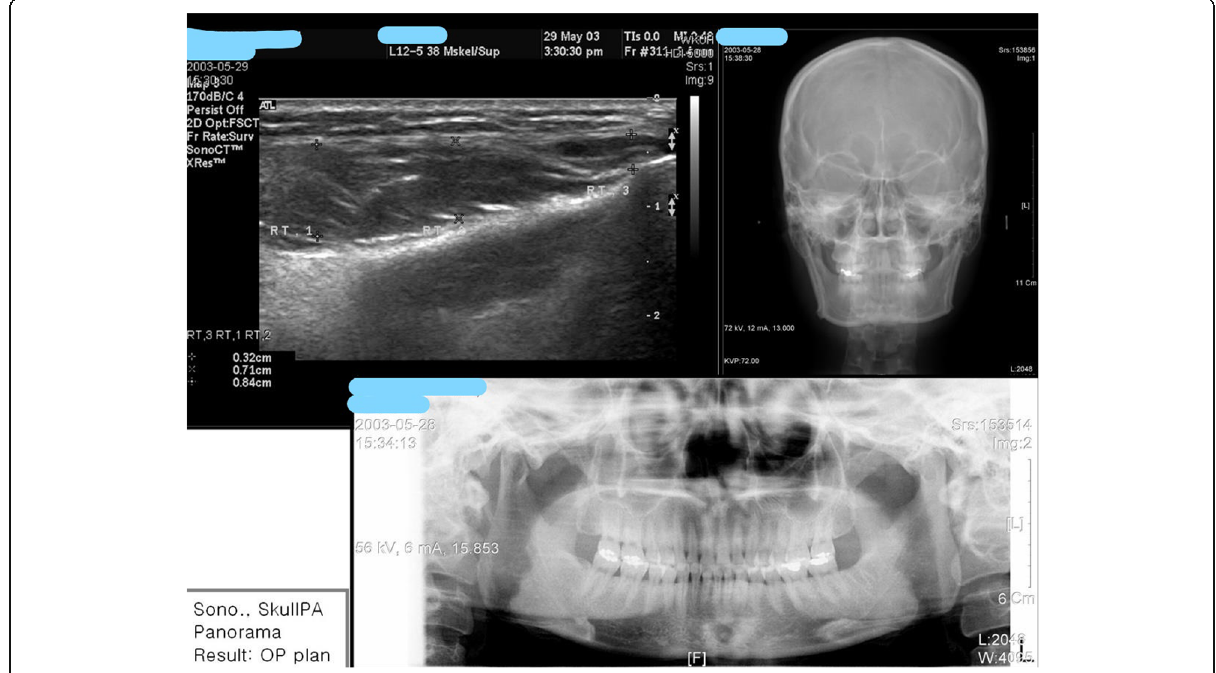
Fig. 9 For an initial assessment of bruxism and square jaw, with tests such as sonography, skull PA, and panorama as seen above, one can examine the degree of contraction or hypertrophy of masseteric muscle of a patient with bruxism or square jaw, and able to identify the temporomandibular joint disorder, determine occlusal relationships, and diagnose pathological diseases. An average of 10 mm or more is determined as masseteric